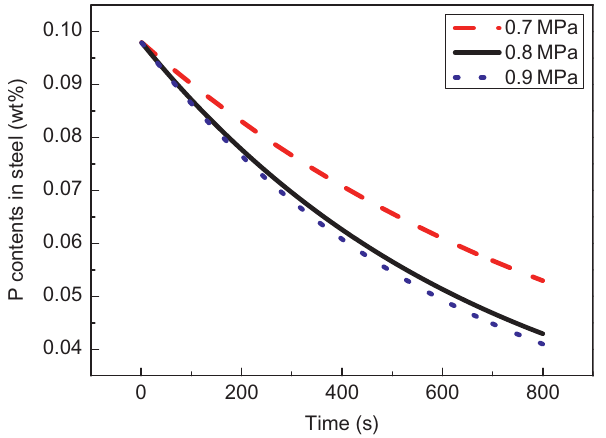
Figure 5: Phosphorus content in steel changing with time at different oxygen pressure.